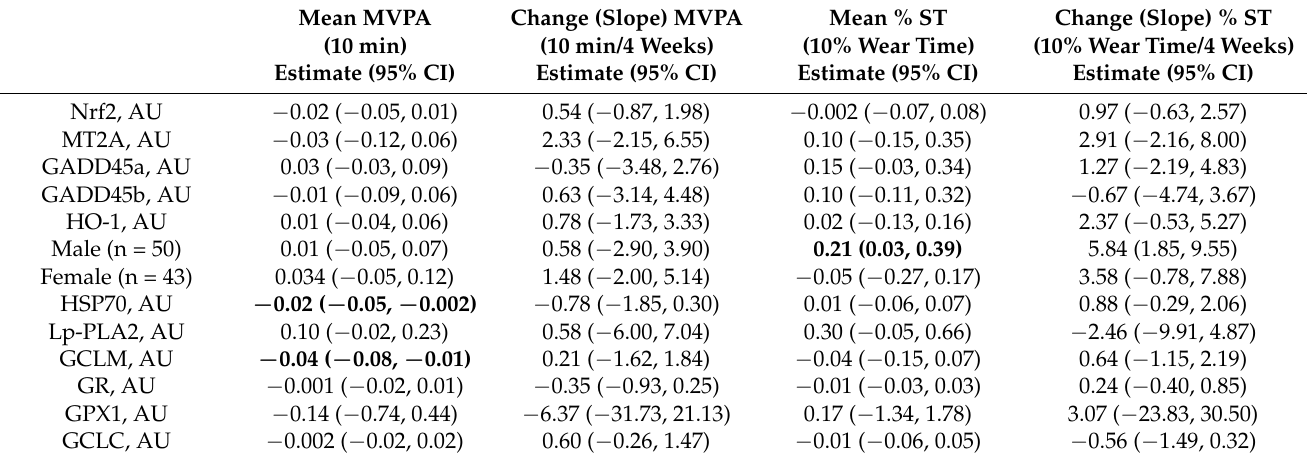
Table 3. The longitudinal association of mean moderate-to-vigorous physical activity (MVPA), changes in MVPA, mean sedentary time (ST) (10% wear time), and changes in ST (slope; 10% wear time/4 weeks) with mRNA expressions in the placenta of obese pregnant